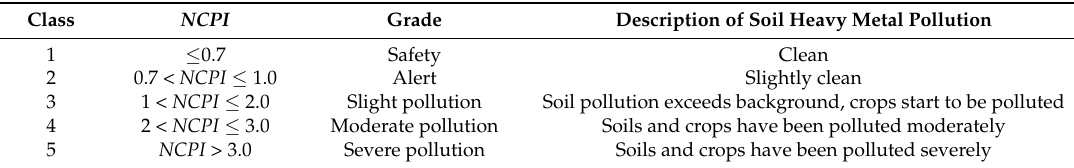
Table 2. Classes of the Nemerow composite pollution index (NCPI).